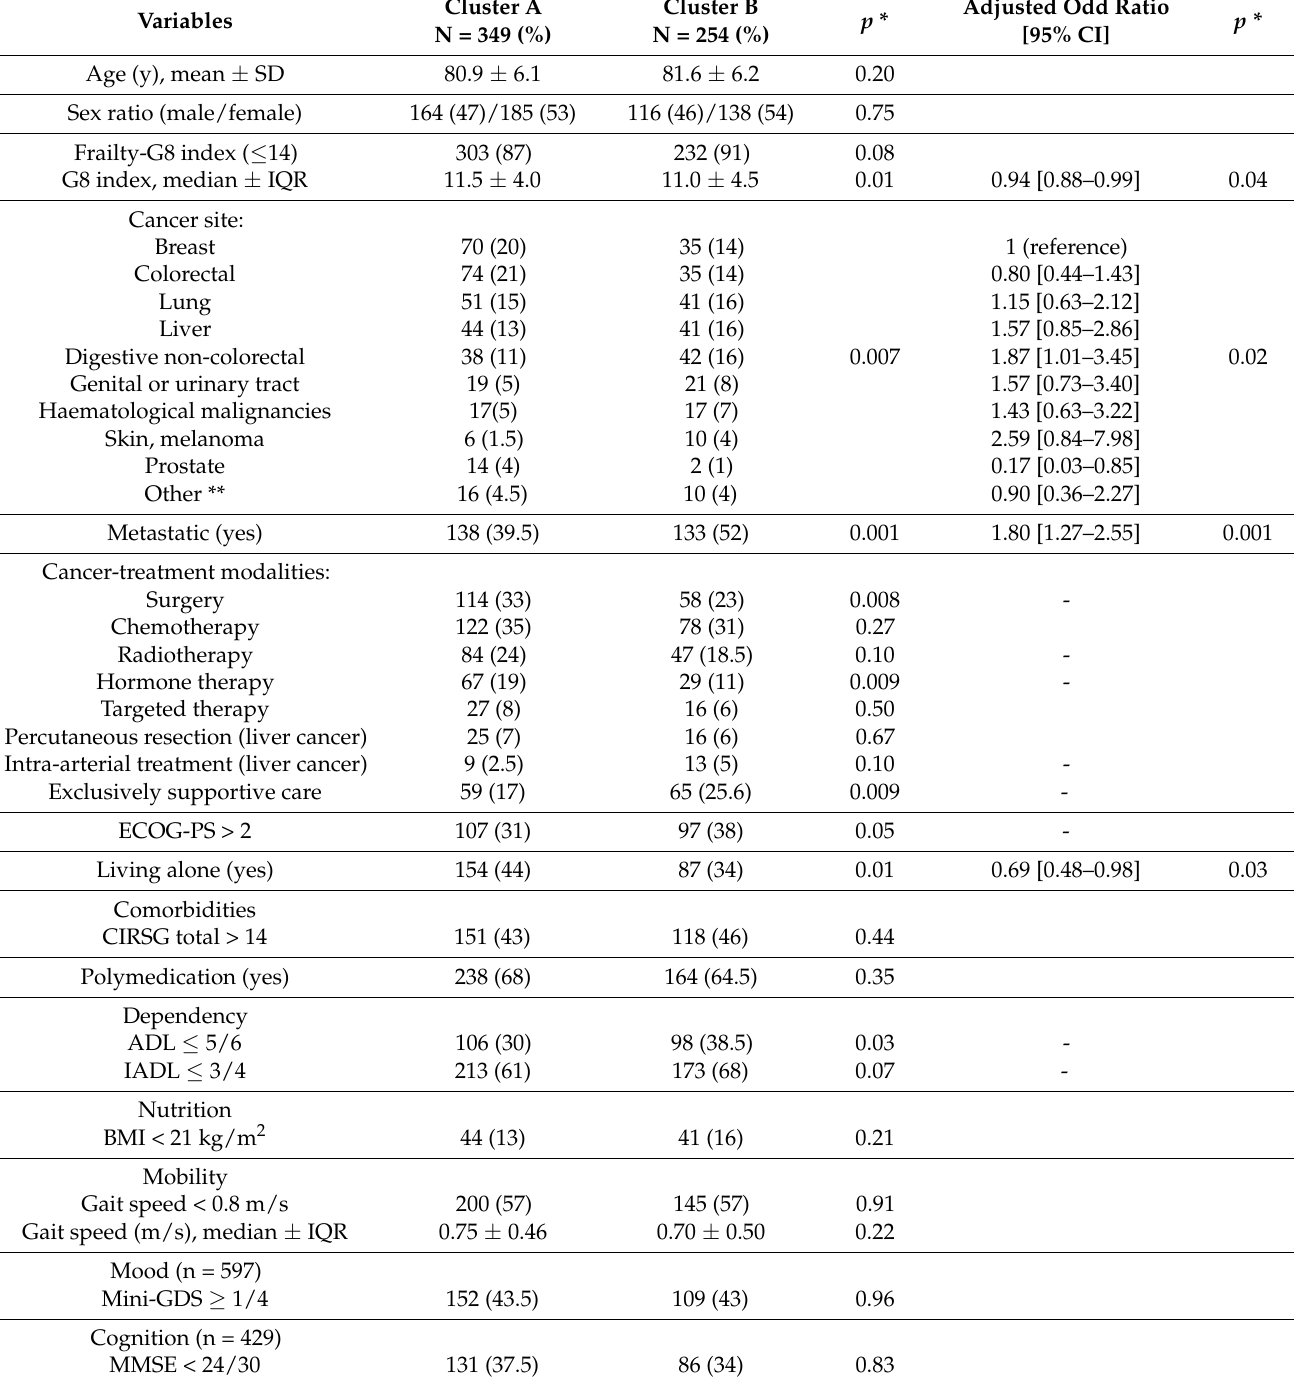
Table 2. Univariate and multivariate factors associated with CAR cluster